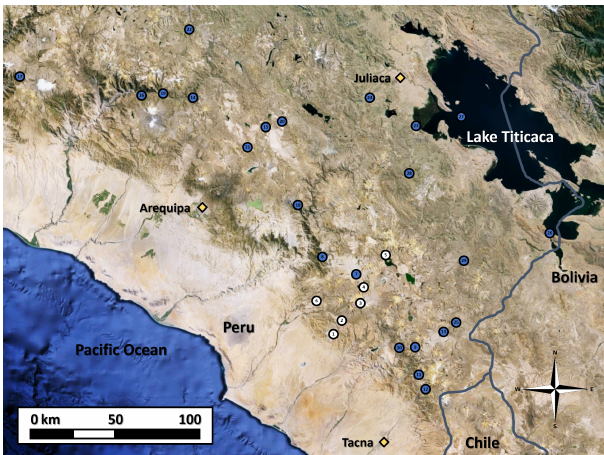
Figure 1. White circles represent locations of SPCC stations; blue circles represent SENAMHI stations. Three major urban centers are labeled and stations are numbered from 1–29 (map generated using Google Earth imagery and station information from